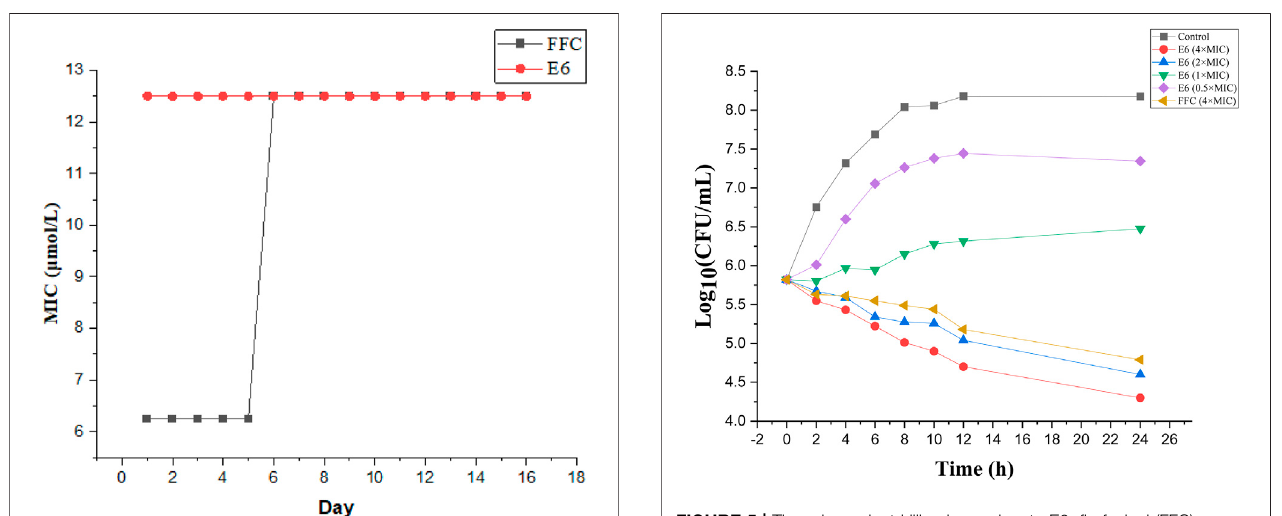
FIGURE 5 | Time-dependent killing by conjugate E6, fl orfenicol (FFC) and the control against E. coli .